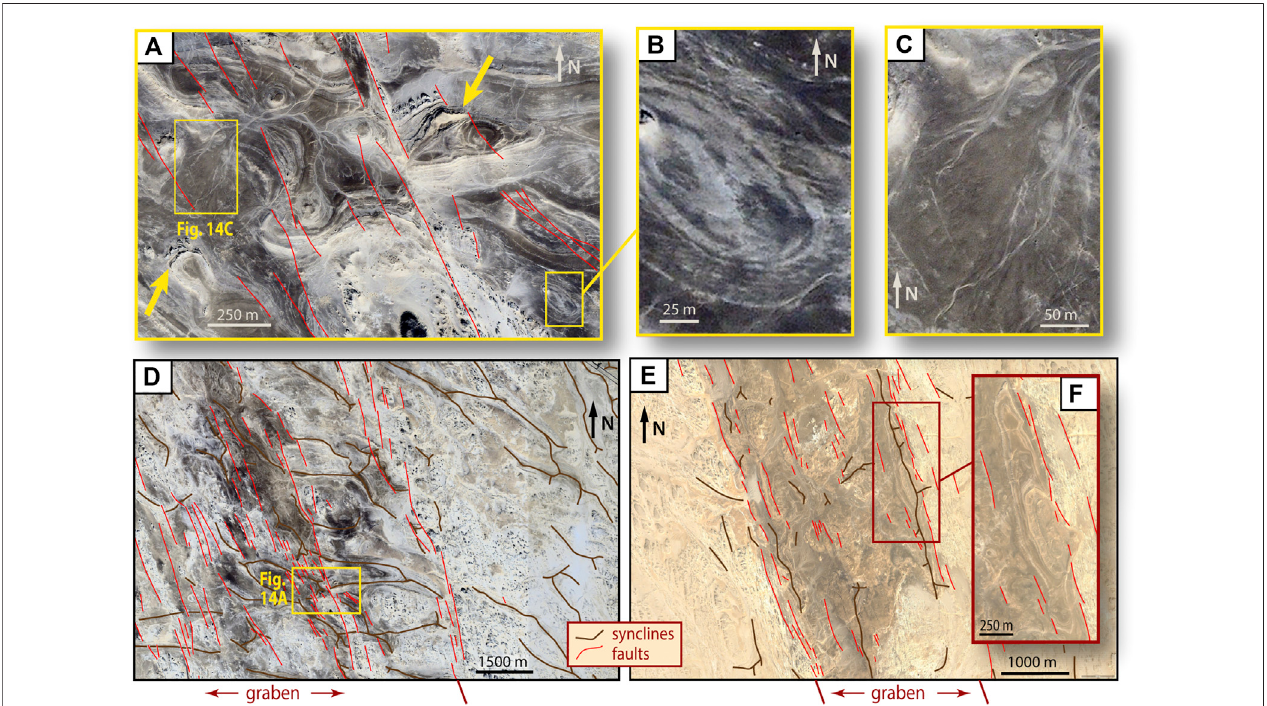
FIGURE 14 | Two areas in the grabens terrain (locations in Figure 7 ) showing synclines and graben-related normal faults. General graben boundaries in (D, E) are based on topographic and satellite image expression of the grabens. (A) Satellite imagery in the grabens is commonly dark, but some places have enough topographic expression (e.g., yellow arrows) to determine dip direction. (B) Bedding commonly ghosts through thin sur fi cial deposits, but determining dip is impossible where topographicreliefislow. (C) Insomeareas,beddingiscompletelymaskedbymobilizeddarksur fi cialmaterial.BecauseofBandC,areasin Figure7 inthegrabens with no mapped synclines should not be taken as syncline-free. (D) Synclines that cut across the graben from adjacent foot wall areas are offset by normal faults within the graben, indicating that these synclines predate the grabens. (E, F) Orientation of synclines parallel to, and just inboard of, graben margin, suggests that